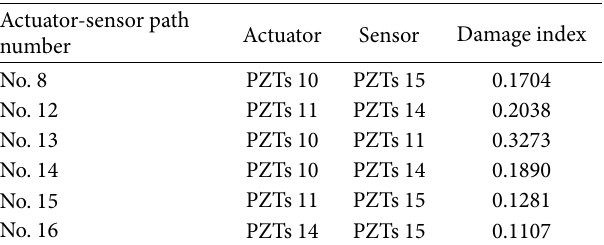
Table 4: The damage indexes of all the actuator-sensor paths of the damage subarea.